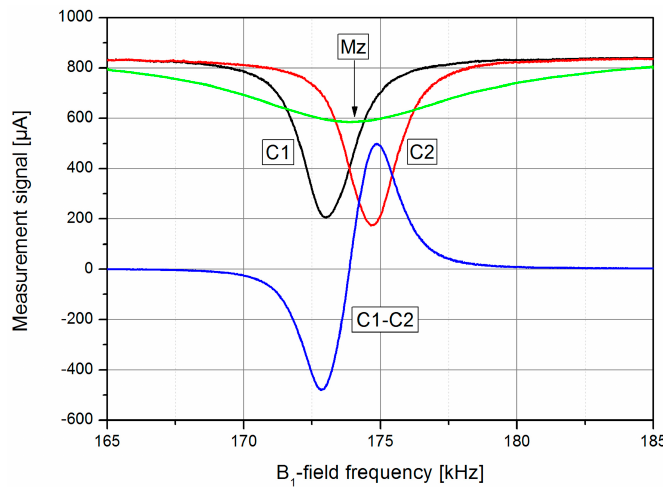
Figure 4. M z signals of two single cells (C1 and C2) pumped in the LN mode with different helicity of the circularly polarized light and LSD-Mz difference signal (C1-C2), in dependence on the B 1 -field frequency (laser pumping power P L = 1.5 mW, cf. later). A conventional M z signal (Mz) with pumping on F = 4 is shown for comparison. The B 0 -field had a value of about 50 μ T.